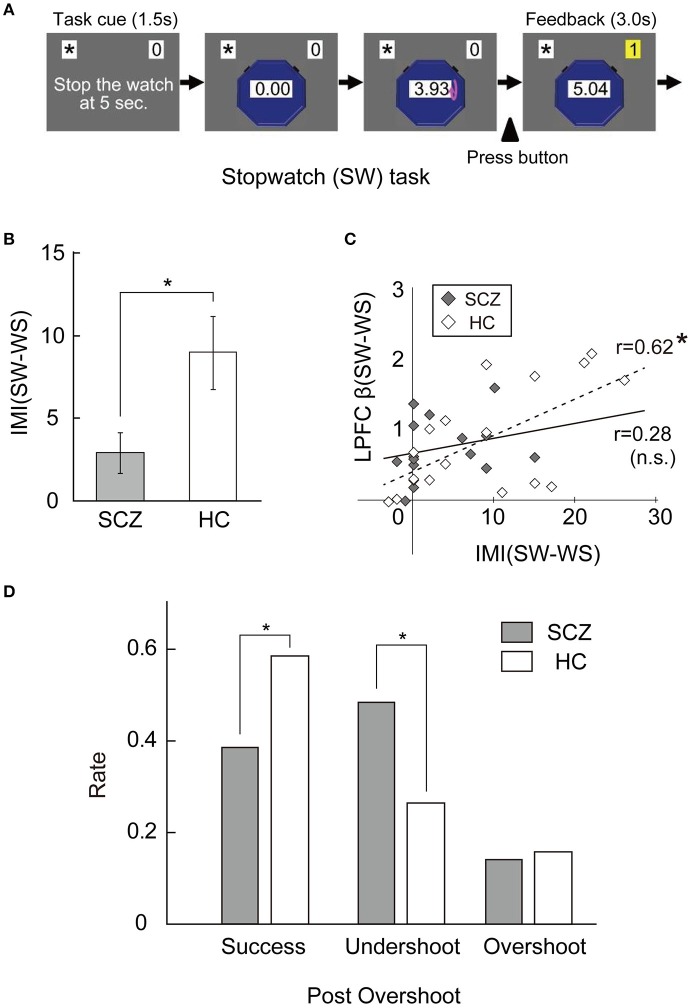
(A) The stopwatch (SW) task. (B) The differences in IMI-SR between SW and WS tasks showed a significant between-group difference. (Mann–Whitney U-test, error bar: SEM, *p < 0.05). (C) In HC, the neural activity in LPFC was positively and significantly correlated with the index of intrinsic motivation, whereas not in SCZ. (Pearson, *p < 0.0125, n.s.: not significant). (D) Comparison of the performance level following the Overshoot between SCZ and HC. There was a significant main effect of Post-Overshoot (Success vs. Undershoot vs. Overshoot) (p < 0.001), and a significant interaction between Post-Overshoot and Group (SCZ vs. HC) (p = 0.01). The secondary analysis for each Post-Overshoot trial revealed a significant main effect of group for Success (p = 0.01) and Undershoot (p = 0.01). These figures modified from Takeda et al. (54).